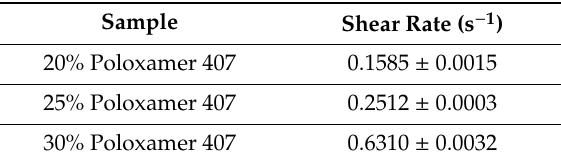
Table 2. Shear rate values correspondent to yield points for 20%, 25% and 30% poloxamer samples. Values are reported as the average of three independent experiments ± standard deviation.